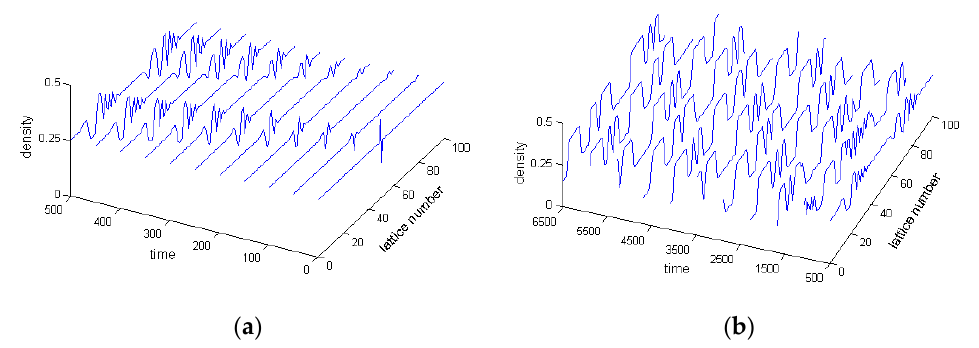
( a ) ( b ) ( a ) ( b ) ( a ) ( b ) Figure 2. Traffic wave-developing process of the new model when =0  and Figure 2. Traffic wave-developing process of the new model when =0  and ( )=round(2+sin( )) d k k , in which ( a ) in the first =500 t time step, ( b ) after =500 t time step. Figure 2. Traffic wave-developing process of the new model when =0  and ( )=round(2+sin( )) d k k , in which ( a ) in the first =500 t time step, ( b ) after =500 t time step. Figure 2. Traffic wave-developing process of the new model when β = 0 and d ( k ) = round ( 2 + ( )=round(2+sin( )) d k k , in which ( a ) in the first =500 t time step, ( b ) after =500 t time step. sin ( k )) , in which ( a ) in the first t = 500 time step, ( b ) after t = 500 time step.